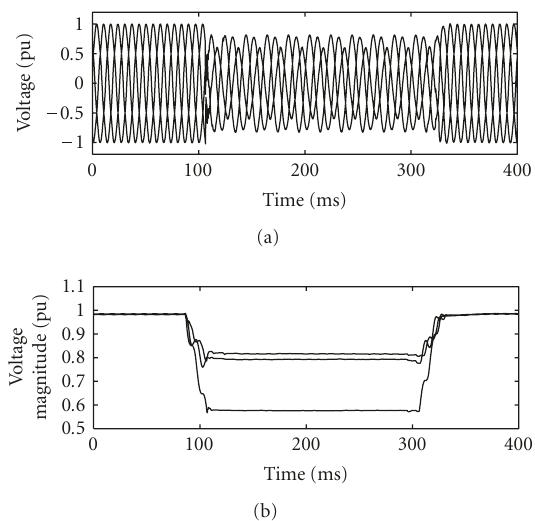
Figure 11: Overvoltage swell due to a fault: (a) voltage waveforms; (b) voltage magnitude (measurement in an 11 kV network).